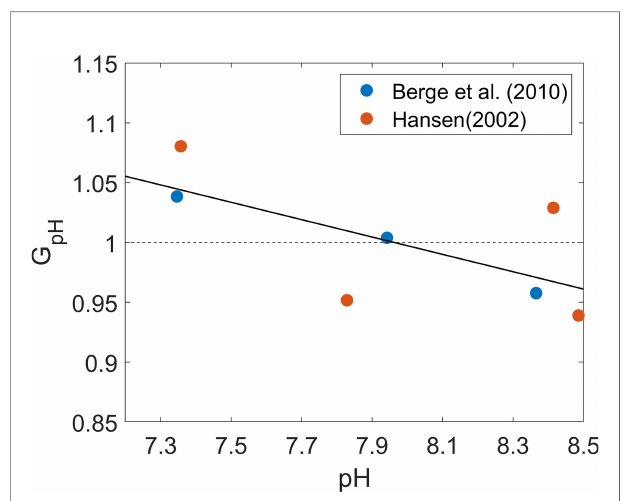
FIGURE 3 | Normalized growth rate of P. minimum (G pH ) as a function of pH. Blue open circles represent data from Berge et al. (2010) and red open circles represent data from Hansen (2002). Both growth rates were normalized by the corresponding mean growth rate under pH ranging from 7 to 8.5 which is a typical range of Chesapeake bay water pH. Solid black line is the fi tted curve which was used in the model considering pH